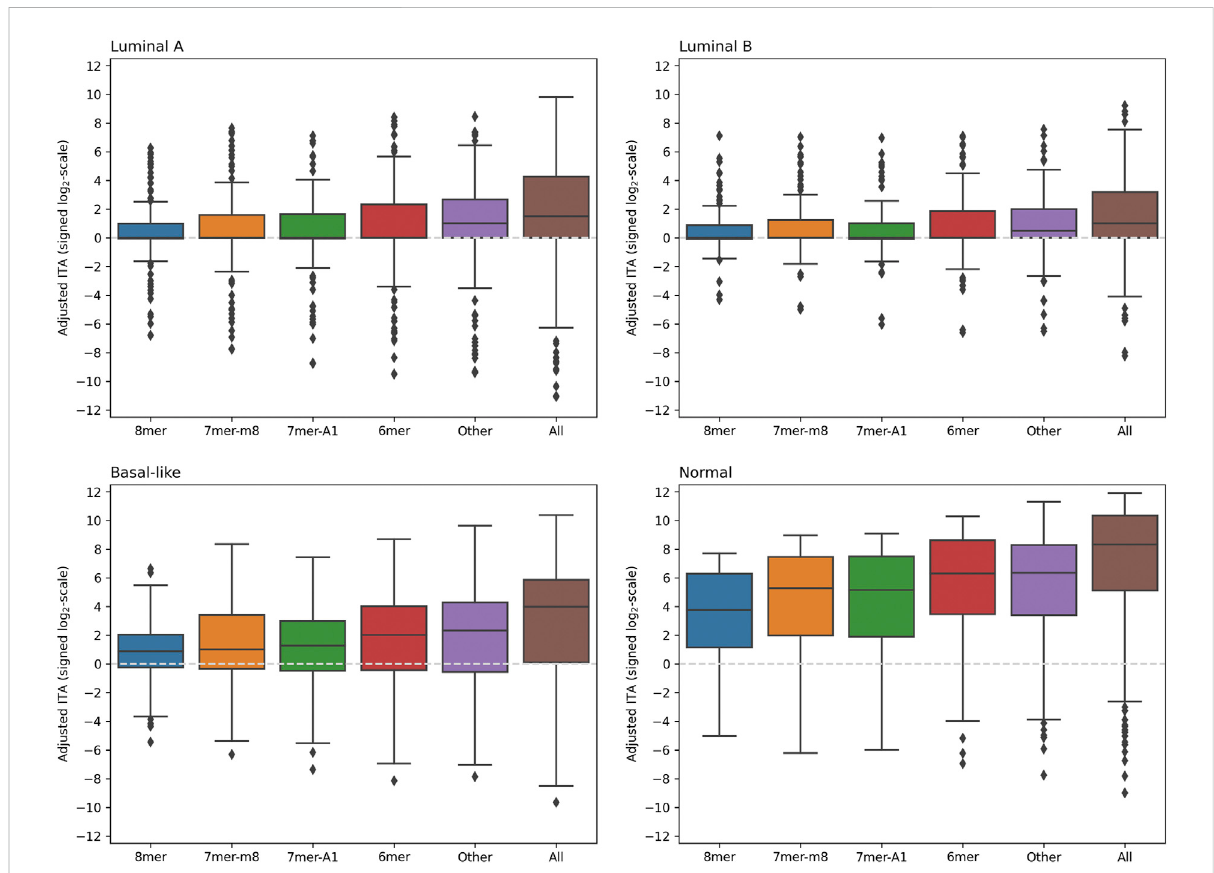
FIGURE 3 The distribution of adjusted ITA values in four groups of samples. The union of RNA22 and TargetScan predictions was used, including RNA22- predicted target sites with non-classical seed binding (labeled as “ Other ” on x -axis) and sites in CDS and 5 ′ -UTR. Adjusted ITA values ( y -axis) were calculatedforeach5 ′ -isomiRandre fl ectthenumberofanti-correlatedpredictedtargetsadjustedforthebackgroundanti-correlations(background was estimated using non-target transcript sequences). To embed positive and negative adjusted ITA values in the logarithmic scale, we applied the following signed log transformation: sgn ( y ) * log 2 (| y | + 1 )